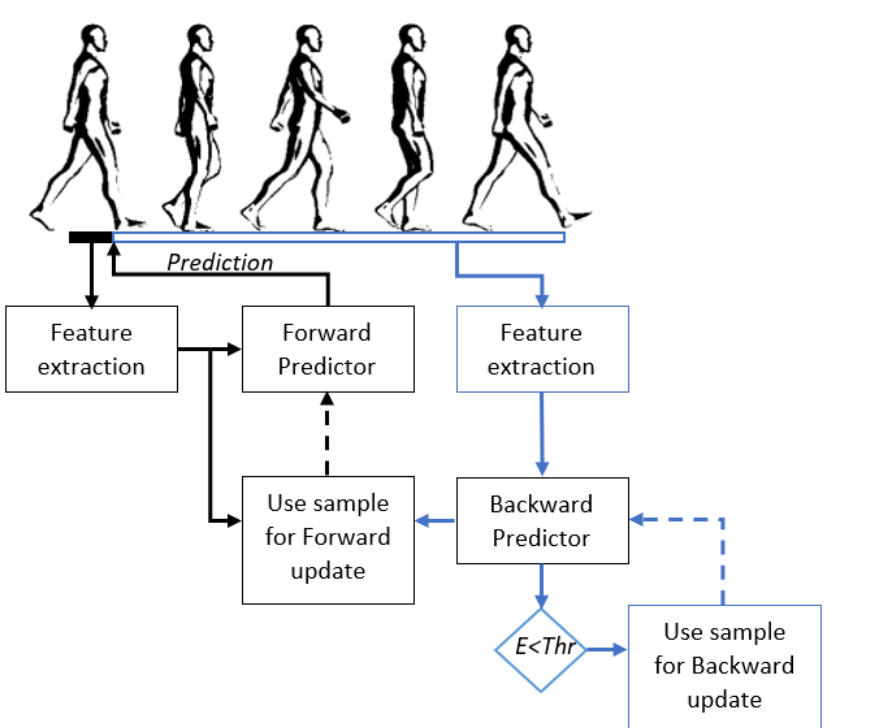
Figure 3. Overview of the backward predictor with entropy adaptation pipeline. First features were extracted from the window before initial contact. The forward predictor used this features to predict the upcoming activity. After a stride the backward predictor predicted the activity of the previous stride. The prediction by the backward predictor was then saved together with the features used by the forward prediction. This sample could then be used for updating the forward predictor. Entropy of the backward prediction was determined using the posterior probability of the backward prediction. If the entropy (E) was below the threshold (Thr) the sample was used for updating the backward